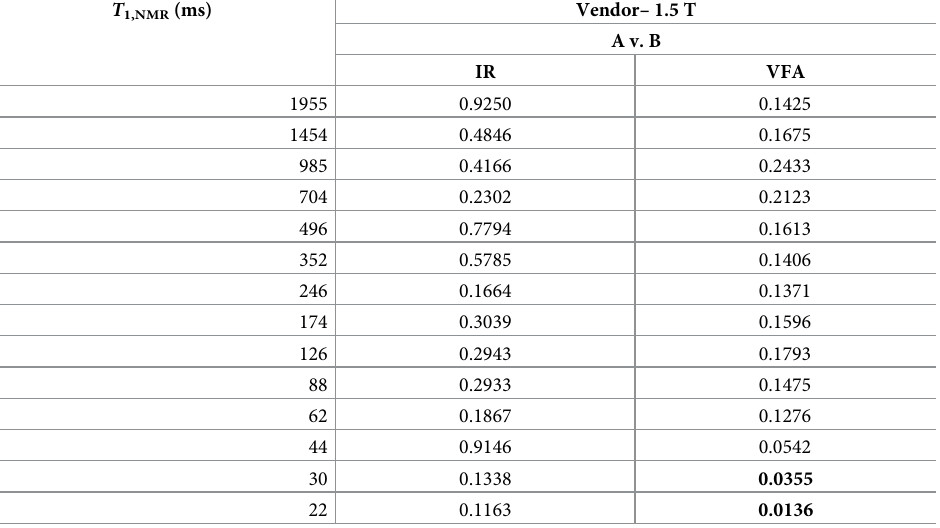
Table 4. ANOVA comparison for IR, VFA at 1.5 T.